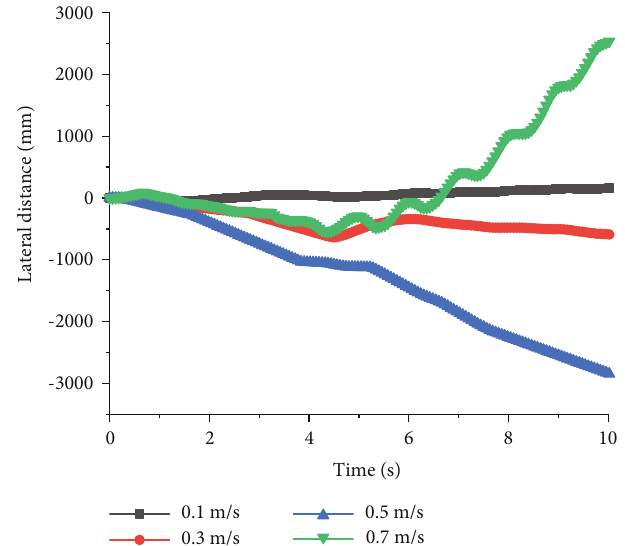
Figure 7: Lateral distances of quadruped robots with full elbow joint with di ff erent speed at a constant